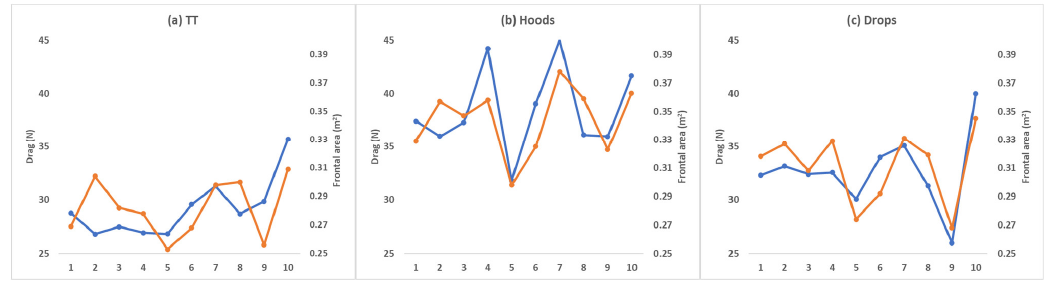
Figure 7. Drag (N, in blue) and area obtained from the projected frontal area camera (m 2 , in orange) for the 10 participants are plotted on primary and secondary axes, respectively. ( a ) TT , ( b ) Hoods , and ( c ) Drops pose.